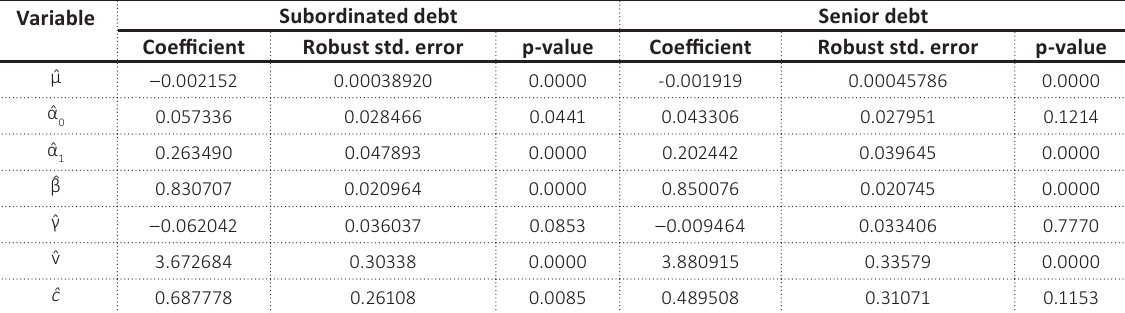
Source: Results from Oxmetrics Professional